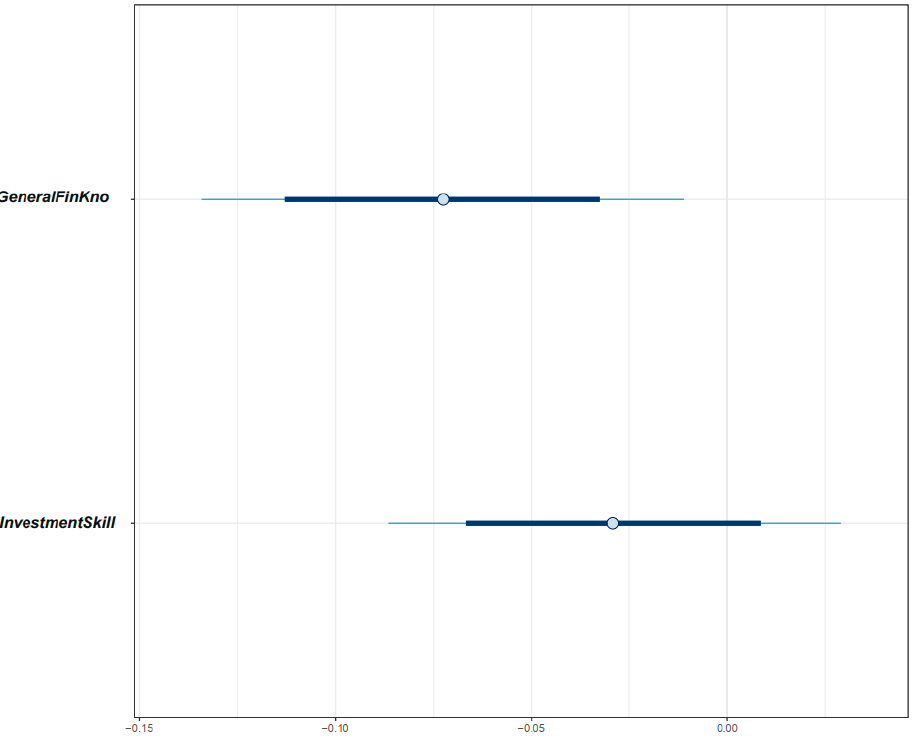
Figure 3. Model 1 ′ s posterior distributions on the interval plot. Figure 3. Model 1’s posterior distributions on the interval plot.